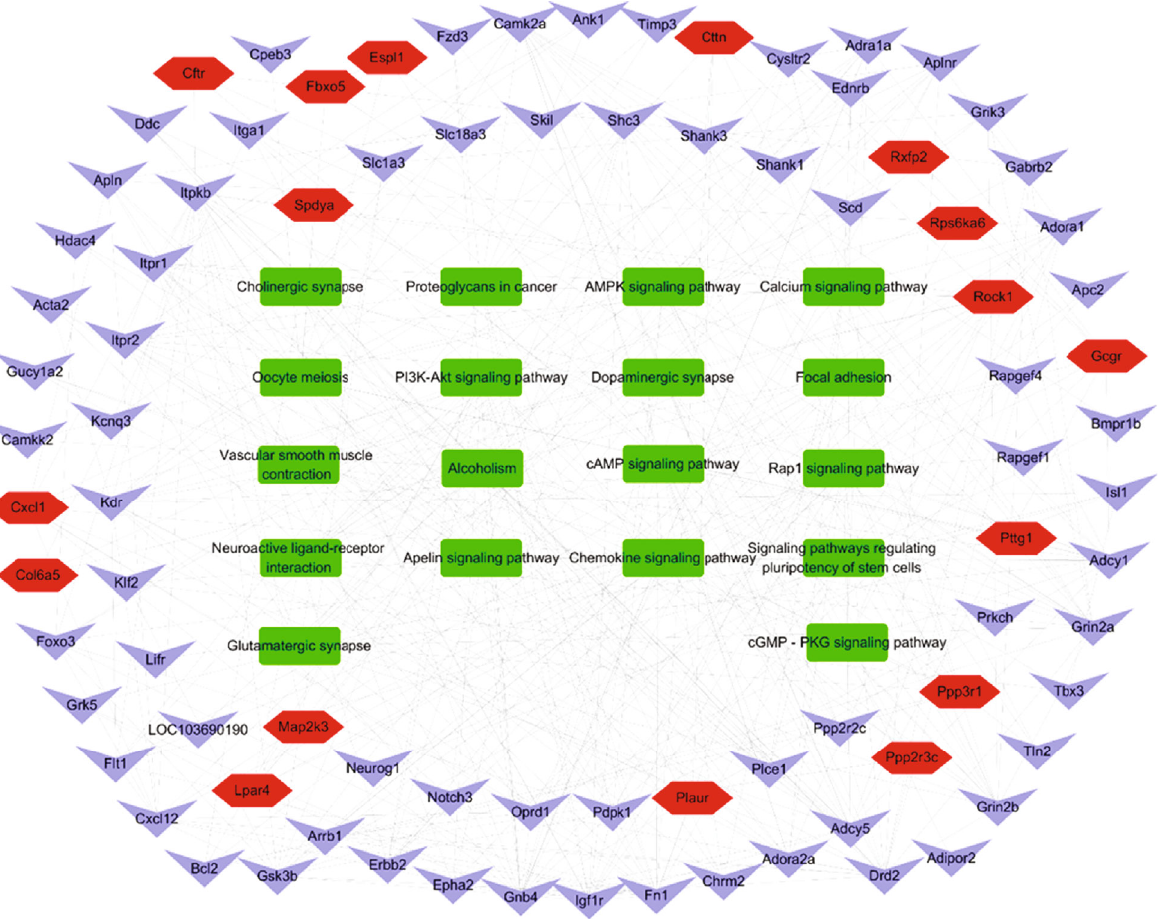
Figure 8: The important pathways and gene network map of PN anti-ischemic stroke. Green represents the pathways, purple represents the downregulated genes, and red represents the upregulated